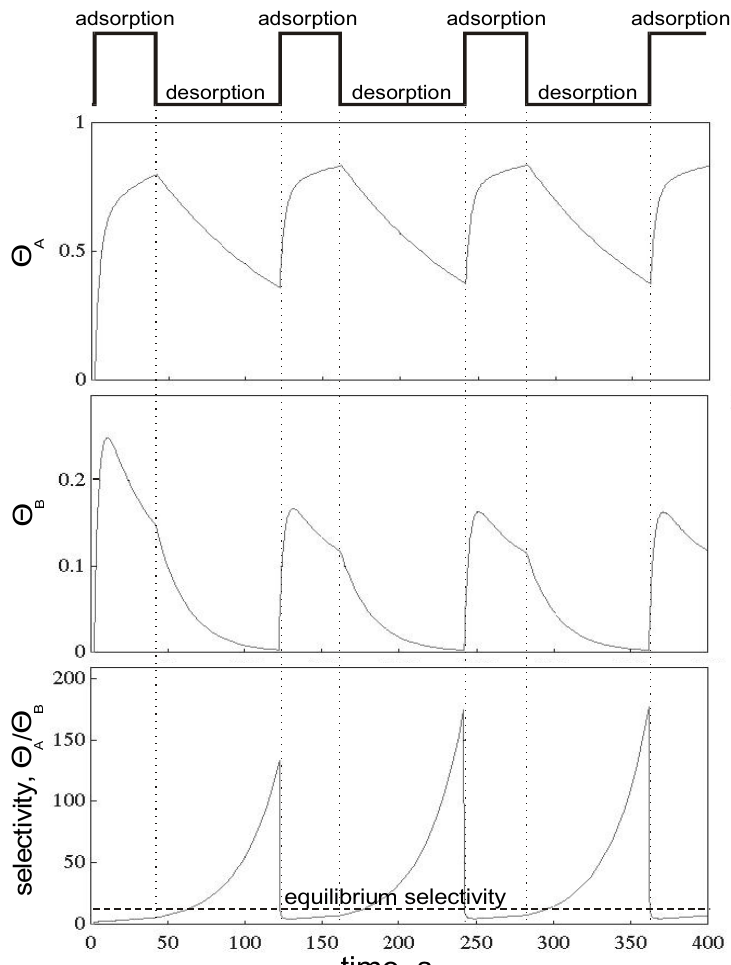
Figure 1. Calculated fractional coverages of receptor layer ( Q for competitive adsorption of species A and B during several adsorption/desorption